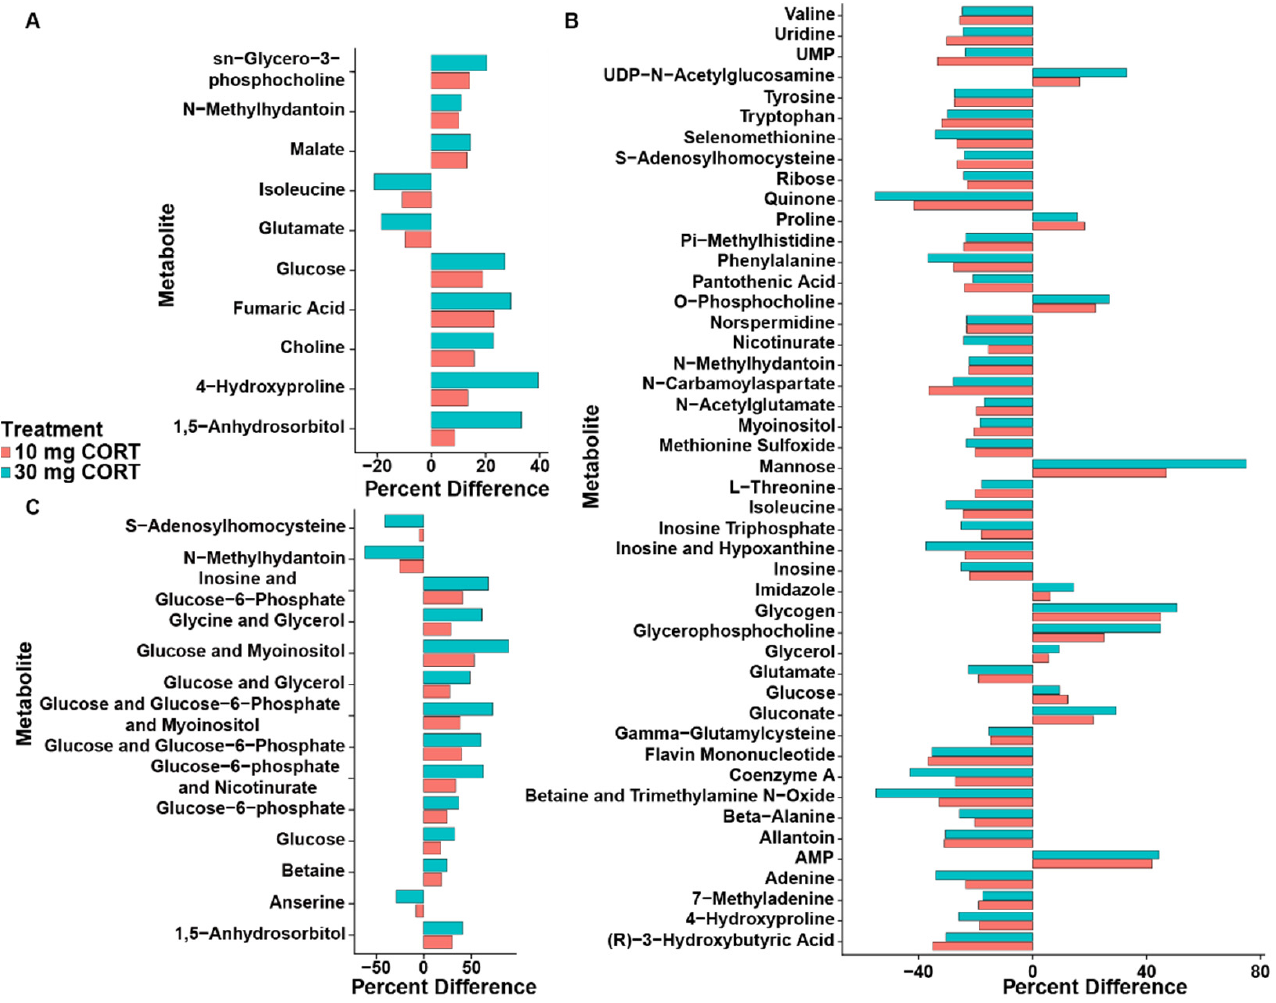
Figure 4. Metabolites significantly altered in both the 10 and 30 mg L − 1 corticosterone treatments. ( A ) Kidney. ( B ) Liver. ( C ) Breast muscle. All metabolites were significantly altered ( p < 0.050) as compared to the ethanol control treatment based on paired t -test and/or multivariate variable importance analysis based on random variable combination analysis.